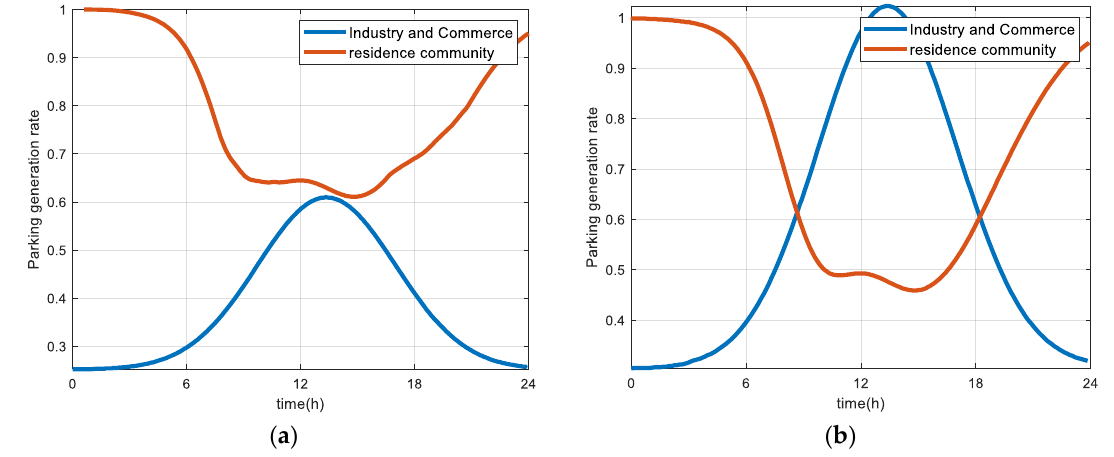
Figure 7. EV parking generation rate: ( a ) non-working day PGR; ( b ) weekday PGR.